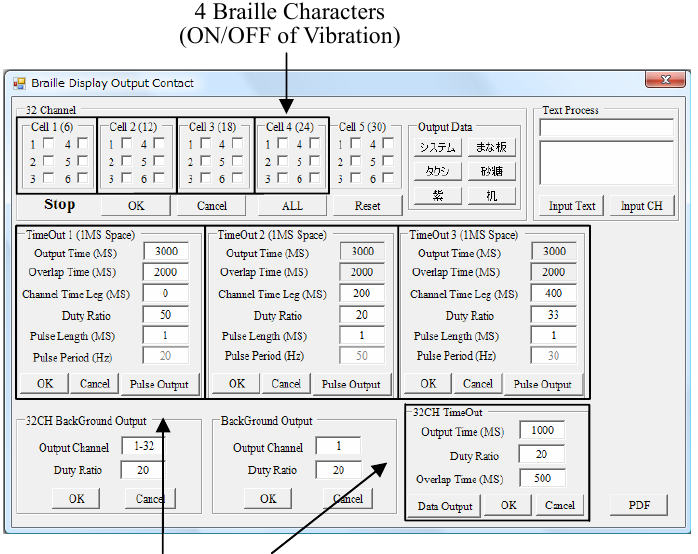
4 Braille Characters (ON/OFF of